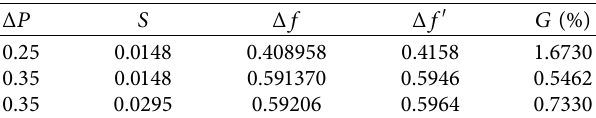
Figure 6: Node frequency characteristic surface under disturbance. Table 2: Verification of the frequency index value when the dis- turbance amount and the electrical distance are, respectively,